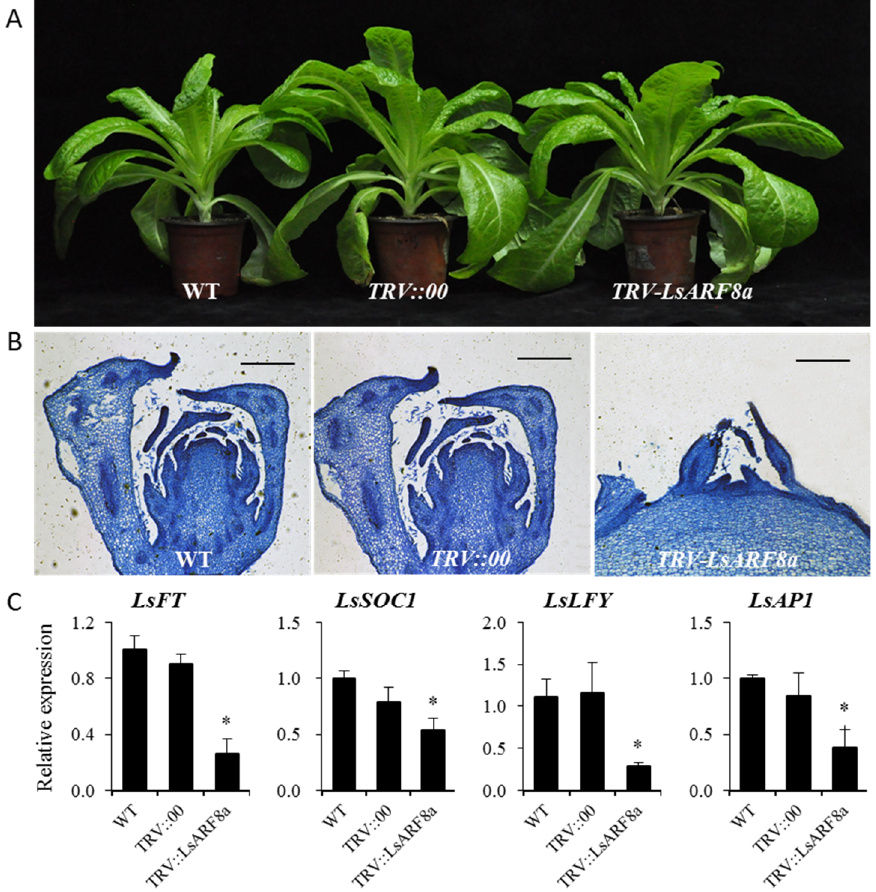
Figure 9. Functional characterization of LsARF8a during the thermally induced bolting in lettuce. ( A ) Phenotypic characterization of TRV2-LsARF8a , TRV:00 , and WT lettuce plants after one-month heat treatments. ( B ) Microscopic observation of shoot apices from TRV:LsARF8a , TRV:00 , and WT lettuce plants after one-month thermal stress. Bar = 200 µ m. ( C ) qRT-PCR analysis of LsFT , LsSOC1 , LsAP1 , and LsLFY in LsARF8a -silencing and control plants. Error bars indicate SE from three biological replicates, and asterisks indicate statistically significant differences between WT and treatments, as determined by Student’s t -test (* p < 0.05).